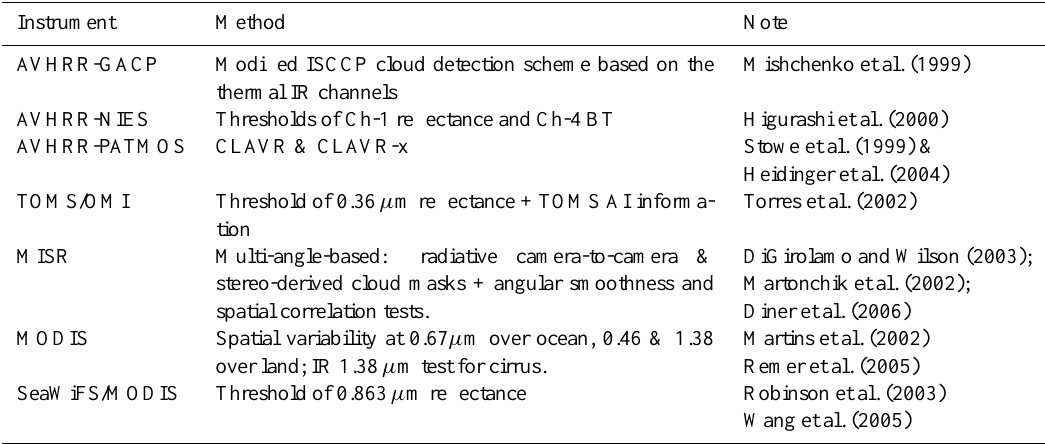
Table 2. Summary of cloud screening schemes for the satellite aerosol